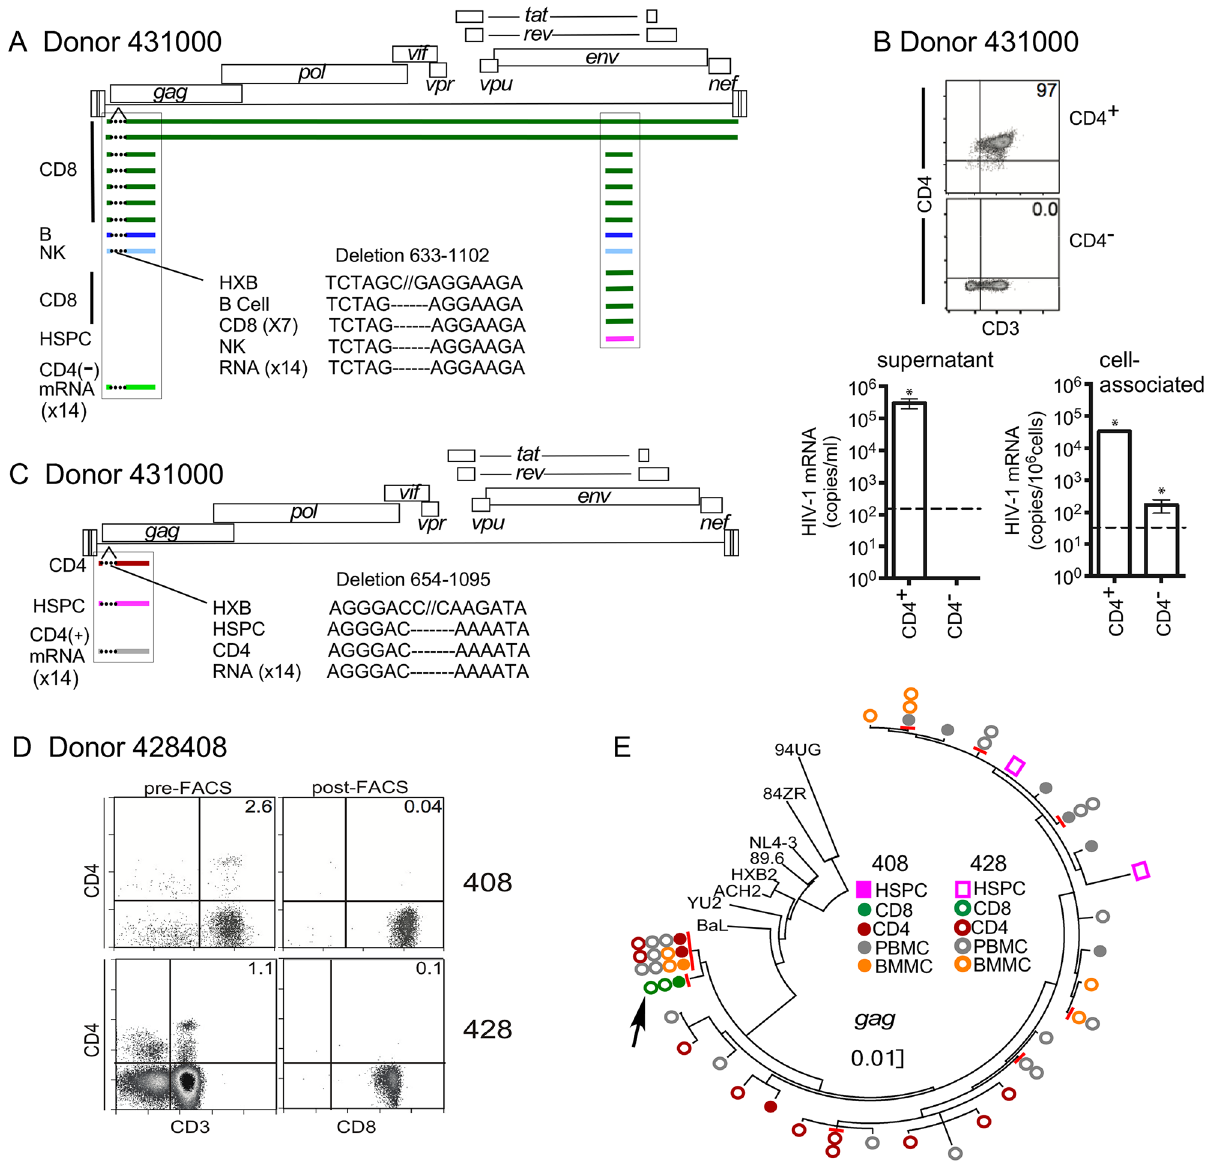
Fig 10. Identical HIV proviral genomes in CD4-negative progeny. A and C. Diagrammatic representation of clonal, defective proviral genomesfrom the indicateddonor 431000cell types. Coloredbars indicateregions of identity. Dotted lines indicatelocation of deletion. White space indicatesregionwhere no sequenceinformation is available. mRNA is cell associatedfrom part B. B, (upper panel)Flow cytometric analysisof purifiedCD4-negativeand CD4 + populationsisolatedfrom donor 431000PBMCs. (Lower panels) Summary graphs of HIV-1 RNA isolatedfrom supernatant (left) and cells (right) followingtreatment with PMA and ionomycin.Dashedline indicateslimit of detection. * p < 0.05D and E. Provirus found in CD4-negativeprogeny can be recovered in two independentdonationsseparatedby months. D. Flow cytometric plots showingpurity of CD4-negative lineages.“Pre” indicates the cell populationpost CD4-beaddepletionand prior to fluorescence activated cell sorting (FACS). “Post” indicatesthe cell populations followingFACS. Numbers in the upper right corner indicate the frequencyof cells in that quadrant.The frequency of CD4 + cells that were also CD3 + by gating was 0% (see also Table 5). E. Phylogenetictree showinggenetic relationships amongst ampliconsfrom two separate donations(408 and 428). Arrow indicateslocation of identical693 bp gag ampliconfrom CD8 cells. (The regionof identity extendedthrough the non-translated LTR regionof the amplicon,which was not includedin the phylogenetic analysis.) Red lines indicateidenticalsequences. Scale indicatesnucleotide substitutionsper site. 89.6, BaL, YU-2, HXB2 and NL4-3 are subtype B HIVs. 84ZR085(84ZR) and 94UG114 (94UG) are subtype D HIV molecularclone outgroups [32]. Phylogenetic analysiswas performed by maximum likelihoodmethod using MEGA7 [33] and history was inferred basedon the Hasegawa-Kishino-Yanomodel [34]. The tree with the highest log likelihoodis shown. Abbreviations: PBMC, unfractionated peripheral blood mononuclear cells; BMMC, bone marrow mononuclear cell (columnflow-through).